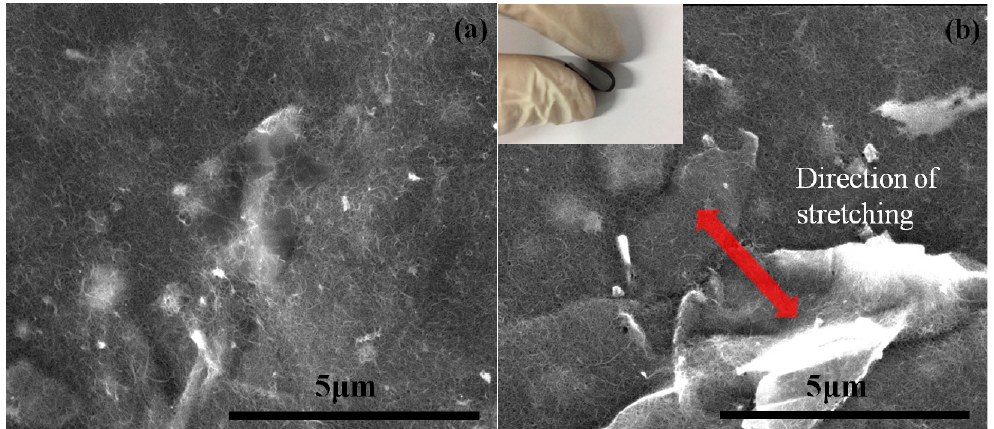
Figure 3. SEM images of the hybrid film GNP-50, ( a ) before and ( b ) after